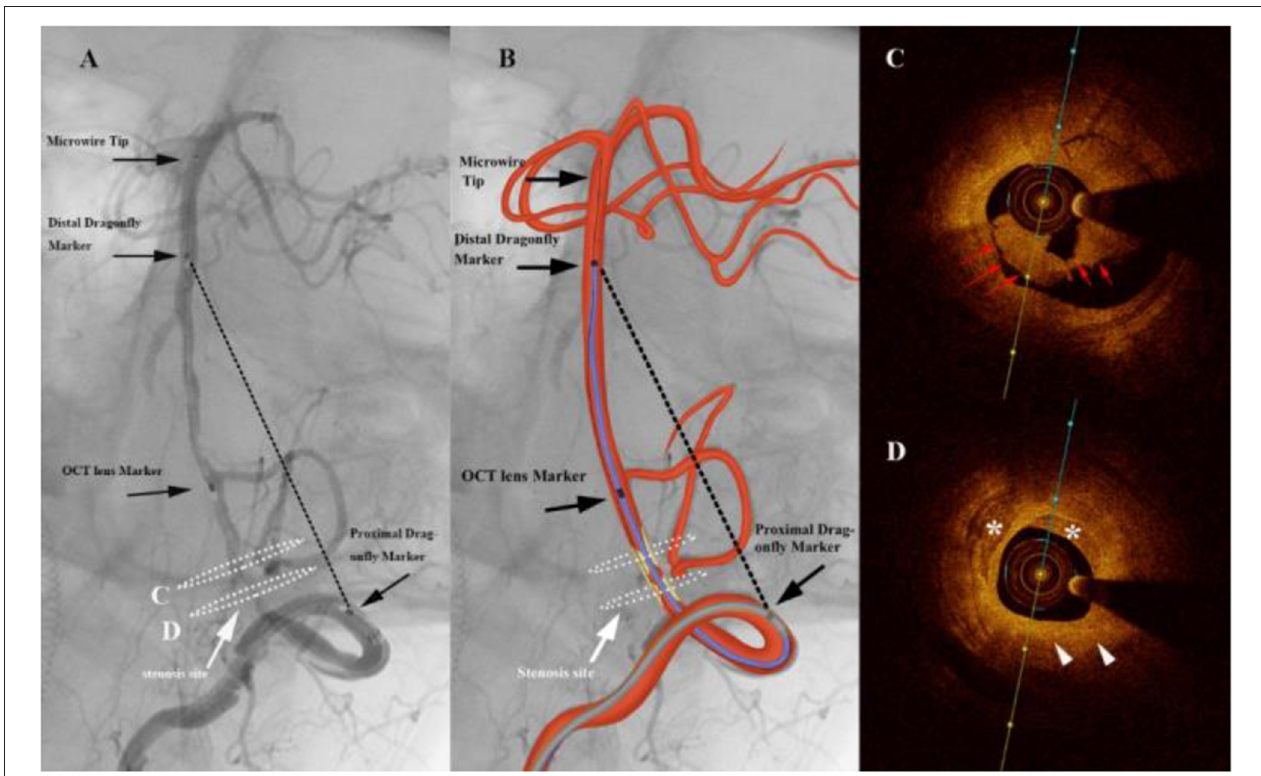
FIGURE 3 | Angiography of a patient complaining of dizziness and slurred speech for 5 months (A) shows a severe stenosis of the vertebral artery (white arrows). The graphic of the imaging catheter and artery is overlaid in the middle panel (B) . The markers of the Dragonfly Duo imaging catheter and the optical coherence tomography (OCT) lens are noted in the left and middle panels (black arrows). The black dashed line represents the linear length between the first and third markers. White dashed ellipses on the left panel correspond to the cross section of the OCT acquisition. (C) Frequency-domain optical coherence tomography (FD-OCT) imaging demonstrated intraluminal thrombosis (red arrows). (D) Atherosclerotic plaque (white arrowheads) with calcification (*) were found at the site of stenosis.